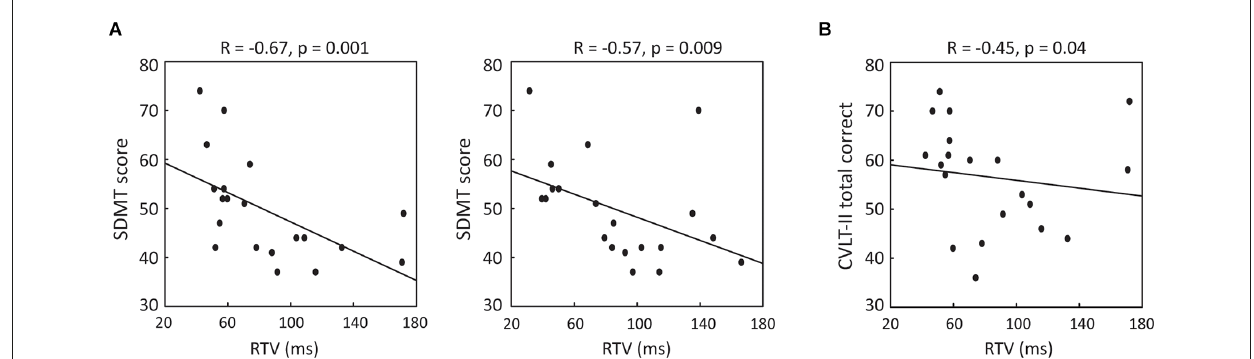
FIGURE3 (A) Association between SDMT score and RTV in WD (left panel) and ND (right panel) conditions. (B) Association between CVLT-II total recall score and RTV in WD condition. WD, with distractors; ND, no distractors; SDMT, Symbol Digit Modalities Test; CVLT, California Verbal Learning